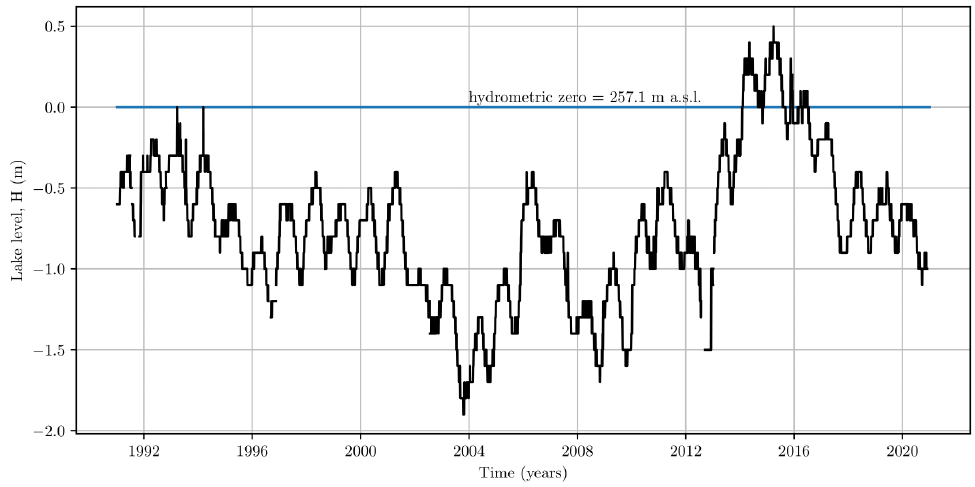
Figure 2. Values of the daily mean level, H , of the Trasimeno lake, measured at the S. Savino weather station, with in blue the hydrometric